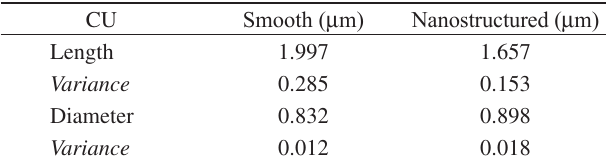
Table 2. Average size of P. fluorescens attached to Cu